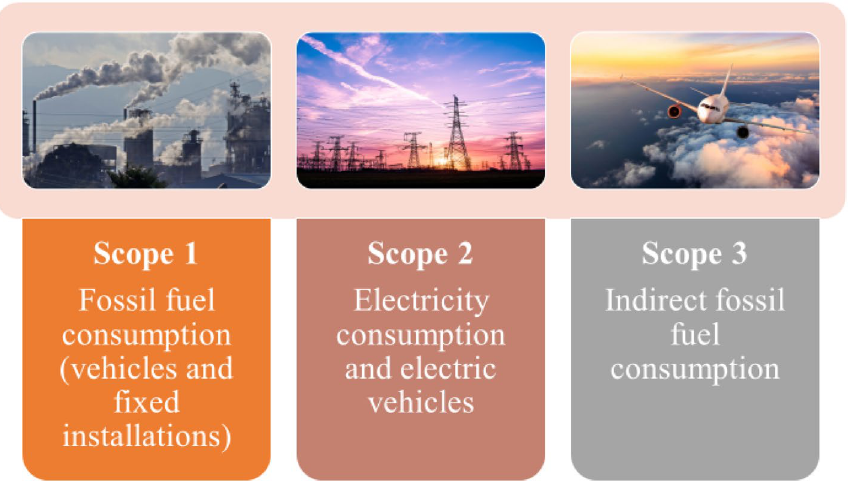
Figure 1. The three scopes of the carbon footprint. Prepared by